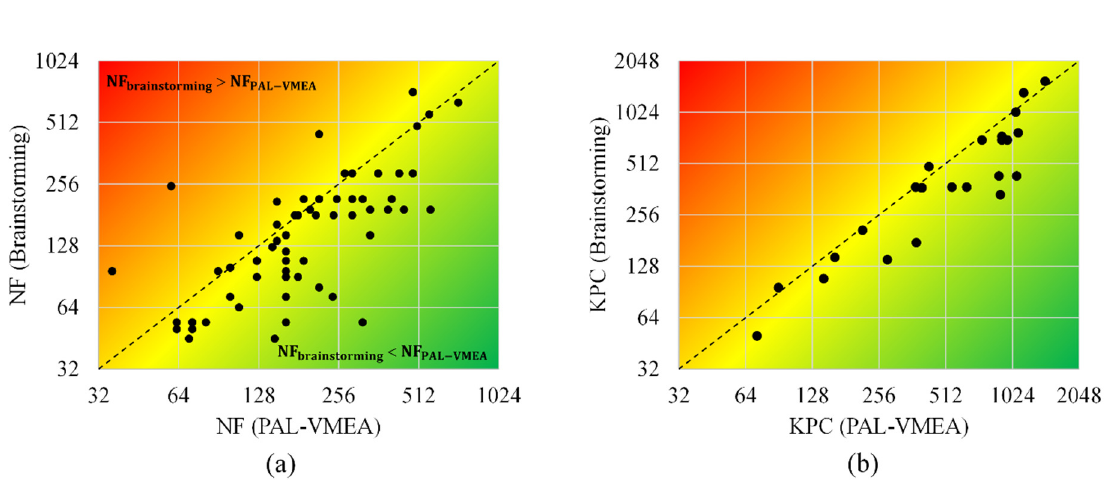
Figure 8. Comparison between the PAL-VMEA method and the brainstorming process results for ( a ) Noise Factors and ( b ) Key Product Characteristics .